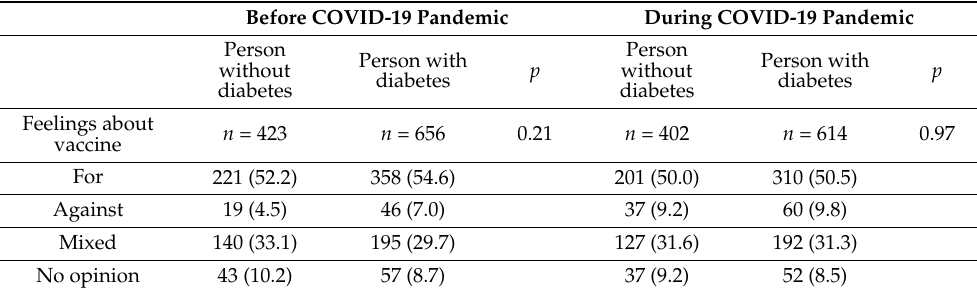
Table 4. Feelings about vaccines and the impact of the COVID-19 pandemic. Before COVID-19 Pandemic During COVID-19 Pandemic Person Person with without diabetes